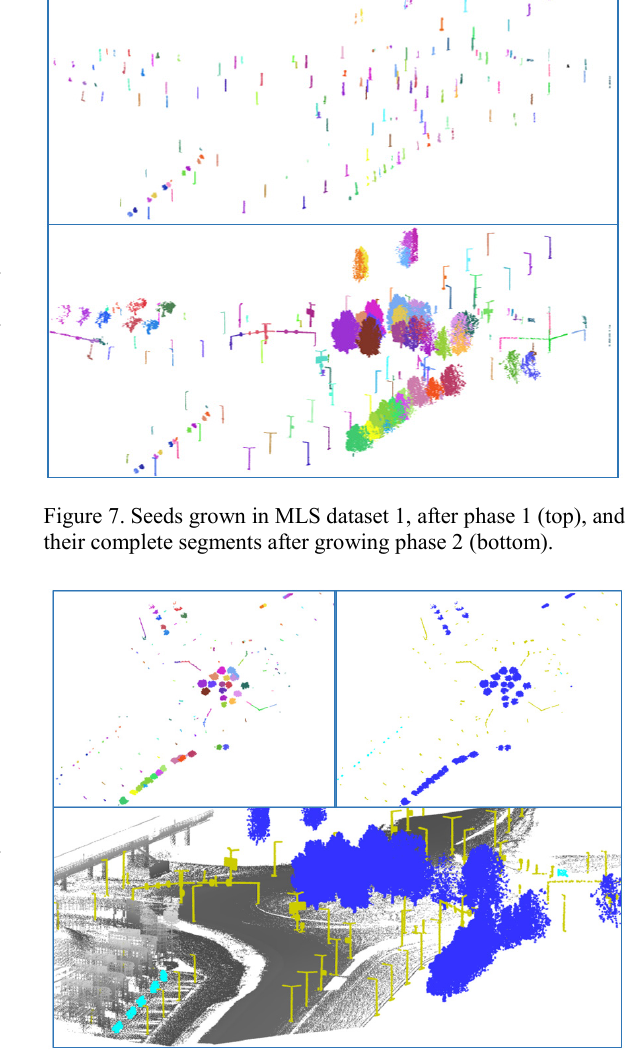
Figure 8. Object segmentation of dataset 1 after the fusion with map points: segmentation (top left), classification (top right), overlaid on the original MLS data